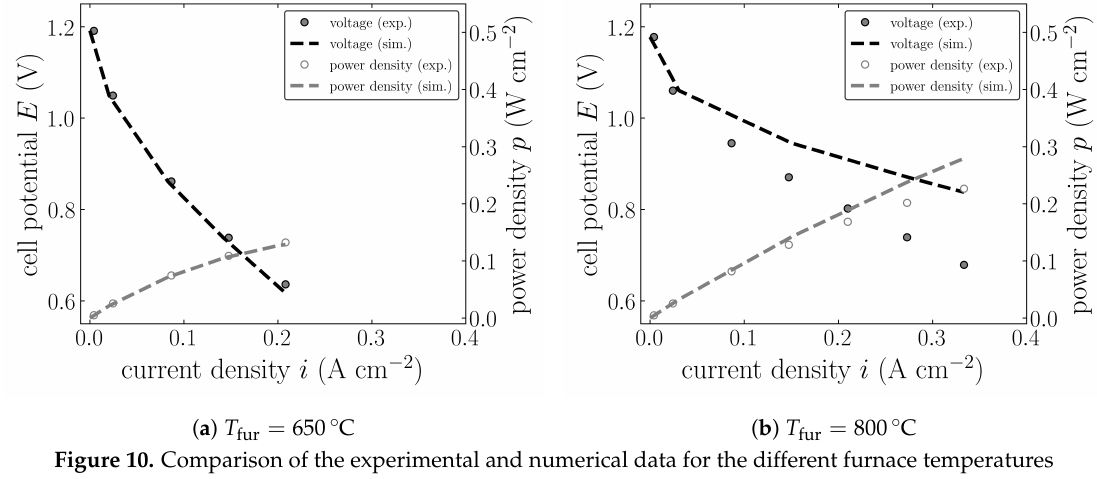
Figure 10. Comparison of the experimental and numerical data for the different furnace temperatures = 0.6, χ = 0.4). ( χ H N 2 2